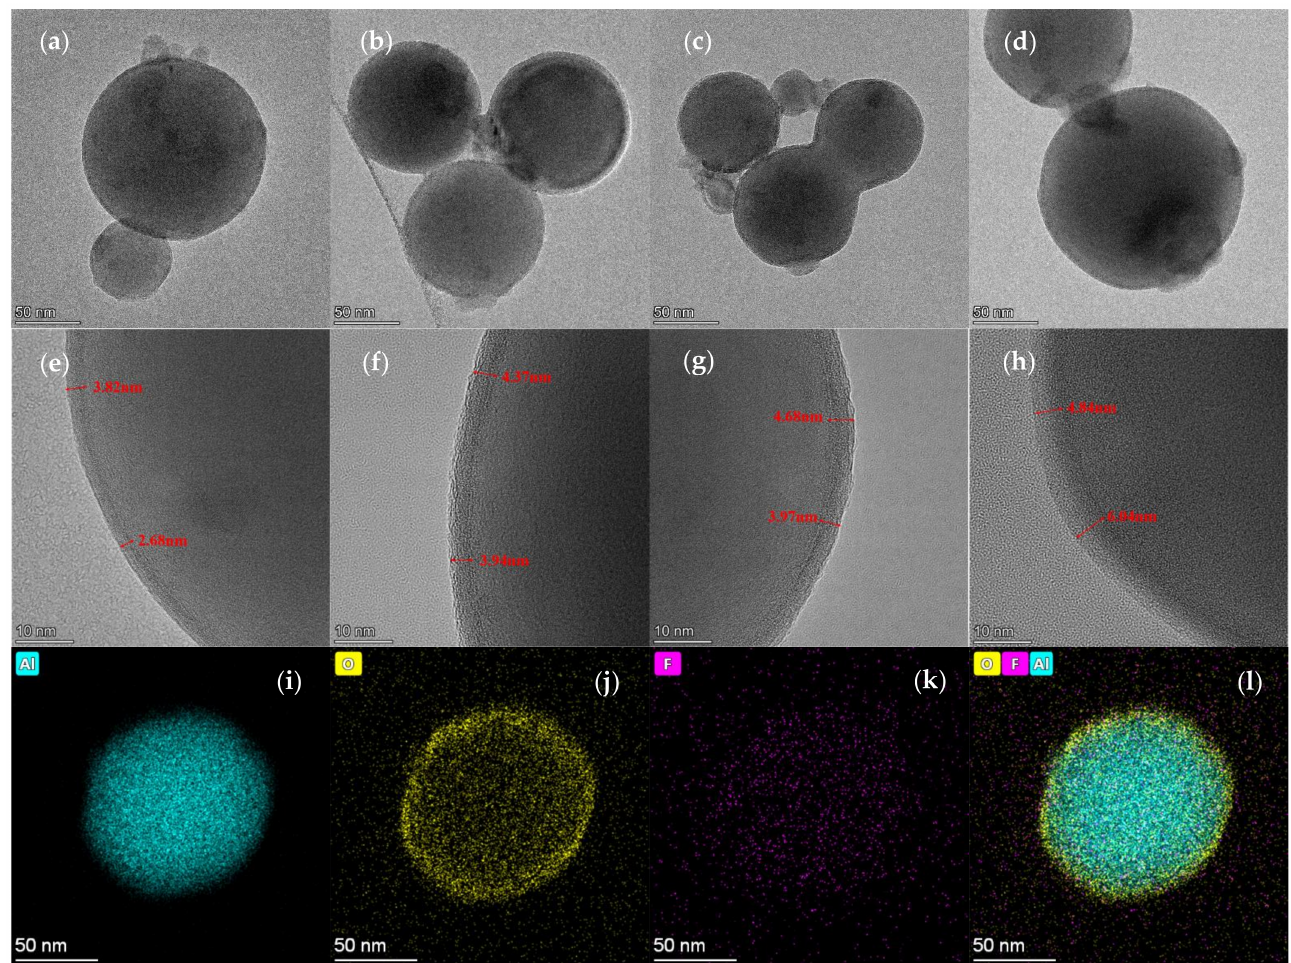
Figure 2. TEM photos of ( a ) Al NPs, ( b ) nAl@2.5%PFPE particles, ( c ) nAl@5.0%PFPE particles, ( d ) nAl@5.0%PFPE particles; high-resolution TEM photos of ( e ) Al NPs, ( f ) nAl@2.5%PFPE particles, ( g ) nAl@5.0%PFPE particles, ( h ) nAl@5.0%PFPE particles; and EDS results showing the distributions of ( i ) Al element (green), ( j ) O element (yellow), ( k ) F element (purple), and ( l ) above-mentioned